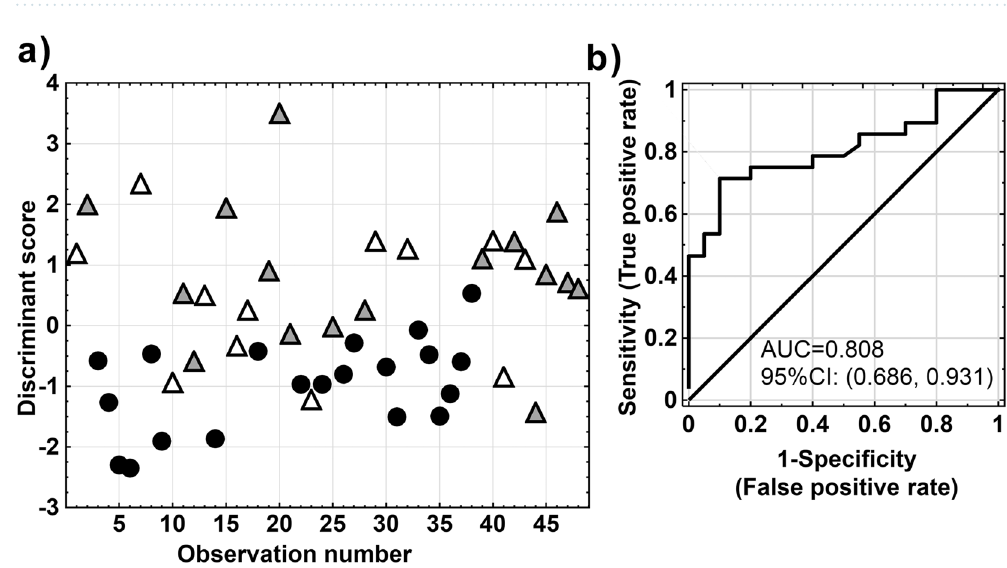
Table 4. Results from the LDA analysis.